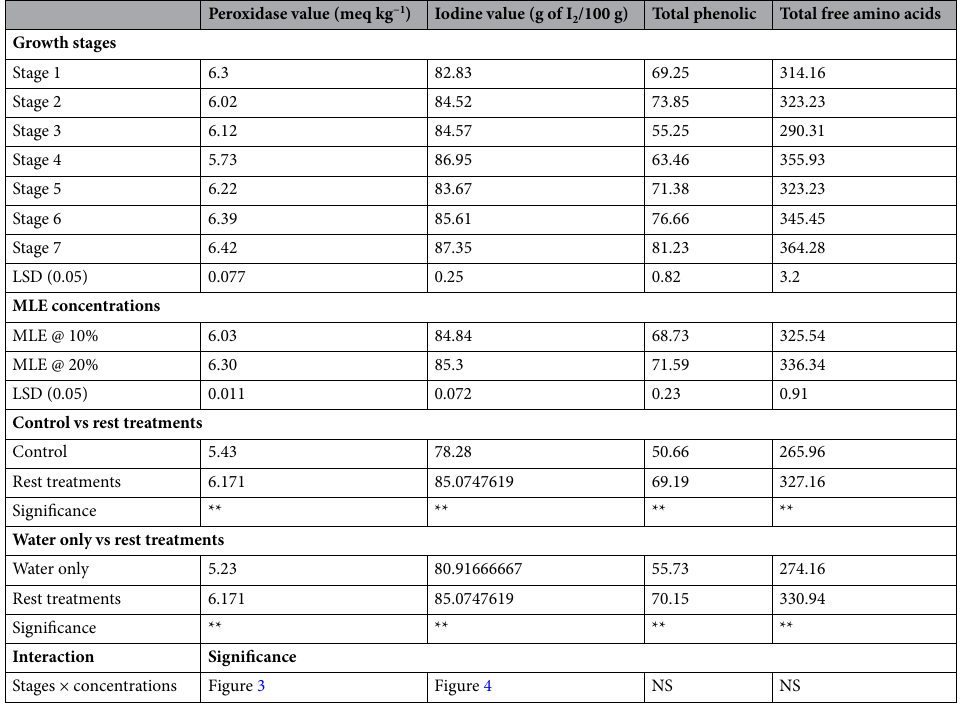
Table 2. Peroxidase value (meq kg −1 ) and Iodine value (g of I 2 /100 g) of black cumin as affected by moringa leaf extract applied at various growth stages. MLE moringa leaf extract, @ at the rate, % percent, Stage 1 application of MLE at 40 DAS, S2 = Application at 80 DAS, S3 = 120 DAS, S4 = 40 + 80 DAS, S5 = 40 + 120 DAS,